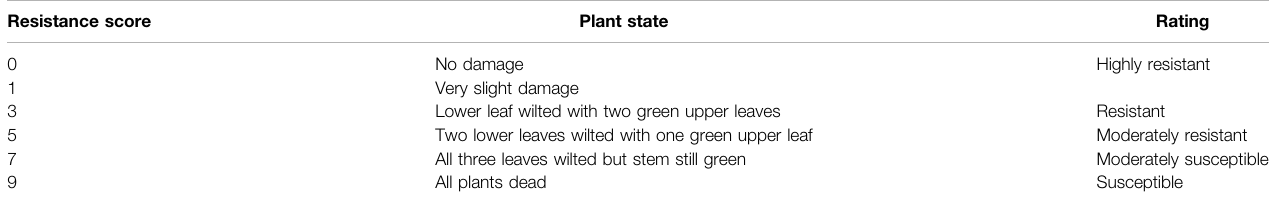
TABLE 2 | Classi fi cation of resistance based on the damage reaction (Standard Evaluation System for Rice, 2013). Resistance